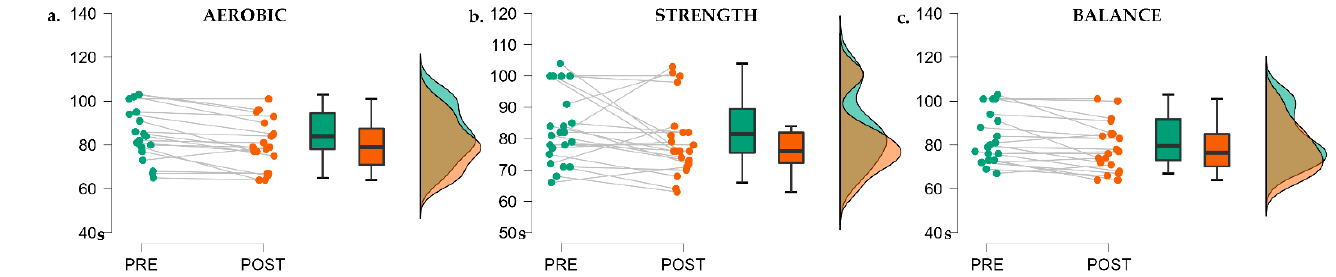
Figure 3. The raincloud plots for the different exercise sessions in the Word Condition. ( a ) Aerobic session. ( b ) Strength session. ( c ). Balance session. Time is measured in seconds ( Y -axis).